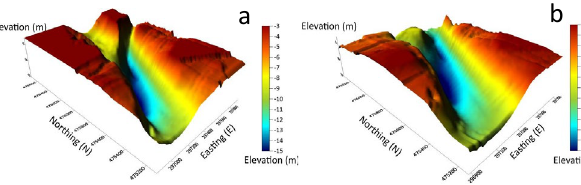
Figure 24. The bathymetric plan generated using Surfer in 3D. a) The bathymetric plan in 2017 and b) the bathymetric plan in